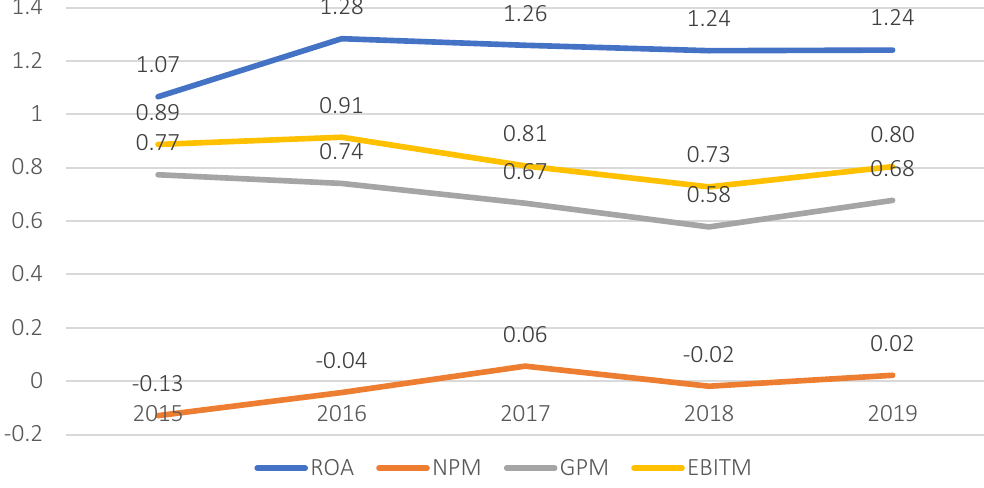
Figure 2. Dynamics of profitability indicators of Slovak software developers for the 2015–2019